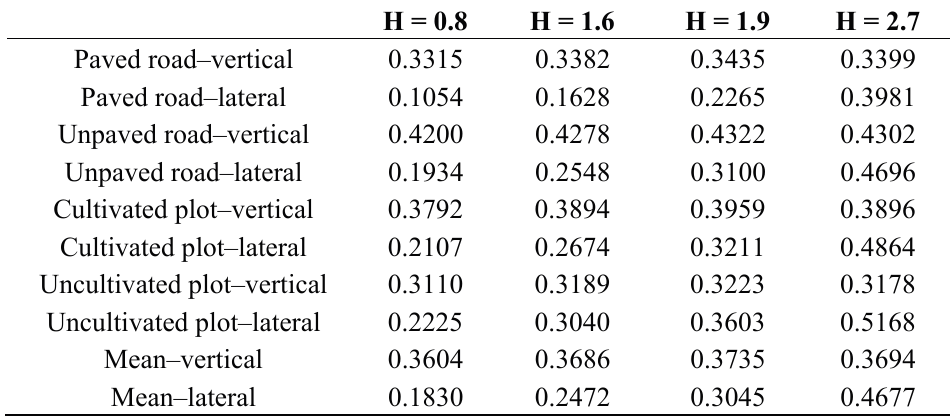
Table 1. Mean acceleration of the vibration signals taking into account only the vibrations falling in the 1–7 Hz frequency band for both vertical and lateral vibration in the experimental test performed over a paved road, an unpaved road, a cultivated plot, and an (cid:3040) uncultivated plot. Numeric values are expressed in (cid:4672) (cid:4673) units. (cid:3046) (cid:3118) H = 0.8 H = 1.6 H = 1.9 H = 2.7